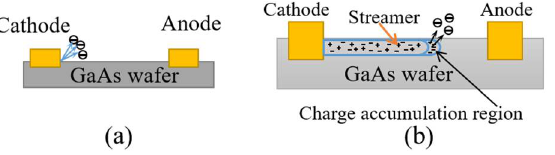
Figure 11. ( a ) Schematic diagram of the field electron emission around the cathode triple junction. ( b ) Schematic diagram of the field electron emission of the streamer head.